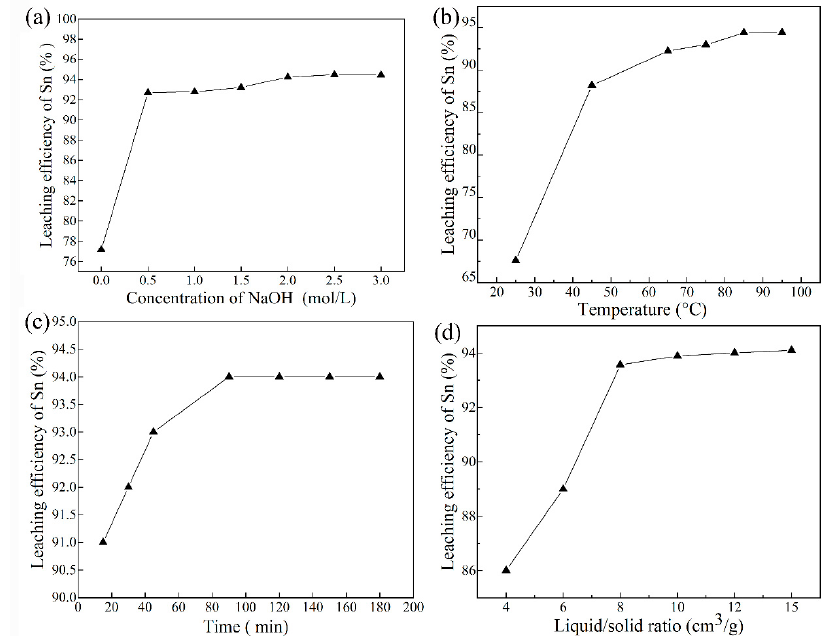
Figure 6. E-pH diagrams of Sn-H 2 O systems at ( a ) 25 °C and ( b ) 100 °C.